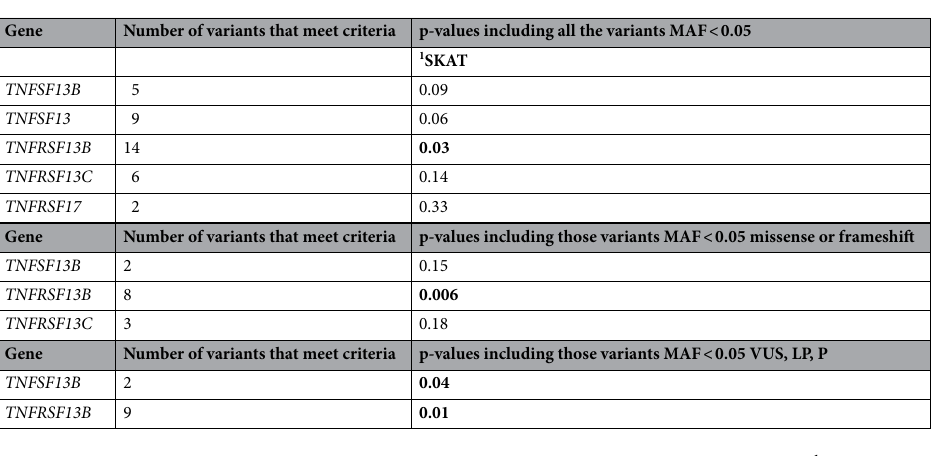
Table 5. Analysis of the association of rare variants in the five genes included in the study. 1 SNP-set (Sequence) Kernel Association Test Method (SKAT, Asymptotic p-value). This test analyzes the association of rare variants (Minor Allele Frequency, MAF < 0.05) grouped by the gene. The p-values < 0.05 were considered significant (shown in bold). VUS variant of uncertain significance, LP likely pathogenic, P pathogenic. Only the genes that met the evaluation criteria are displayed. The rest of the genes could not be evaluated with the corresponding filter because they did not have at least two rare variants that meet the condition.